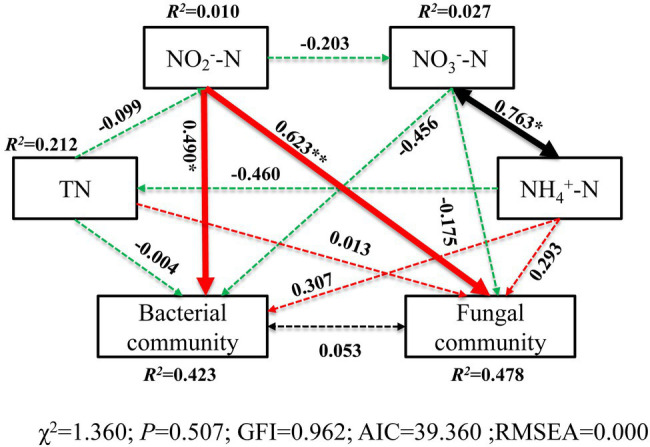
Structural equation model (SEM) illustrating the effects of soil properties on microbial communities. Continuous and dashed arrows represent the significant and non-significant relationships, respectively. Adjacent numbers that are labeled in the same direction as the arrow represents path coefficients, and the width of the arrow is in proportion to the degree of path coefficients. Green and red arrows indicate positive and negative relationships, respectively. Black arrows indicate integrations. R
2 values indicate the proportion of variance explained by each variable. Significance levels are denoted with *
p < 0.05 and **
p < 0.01. Standardized total effects (direct plus indirect effects) calculated by the SEM are displayed below the SEM. The low chi-square (χ
2), non-significant probability level (p > 0.05), high goodness-of-fit index (GFI > 0.90), low Akaike information criteria (AIC), and low root-mean-square errors of approximation (RMSEA < 0.05) listed below the SEMs indicate that our data matches the hypothetical models.